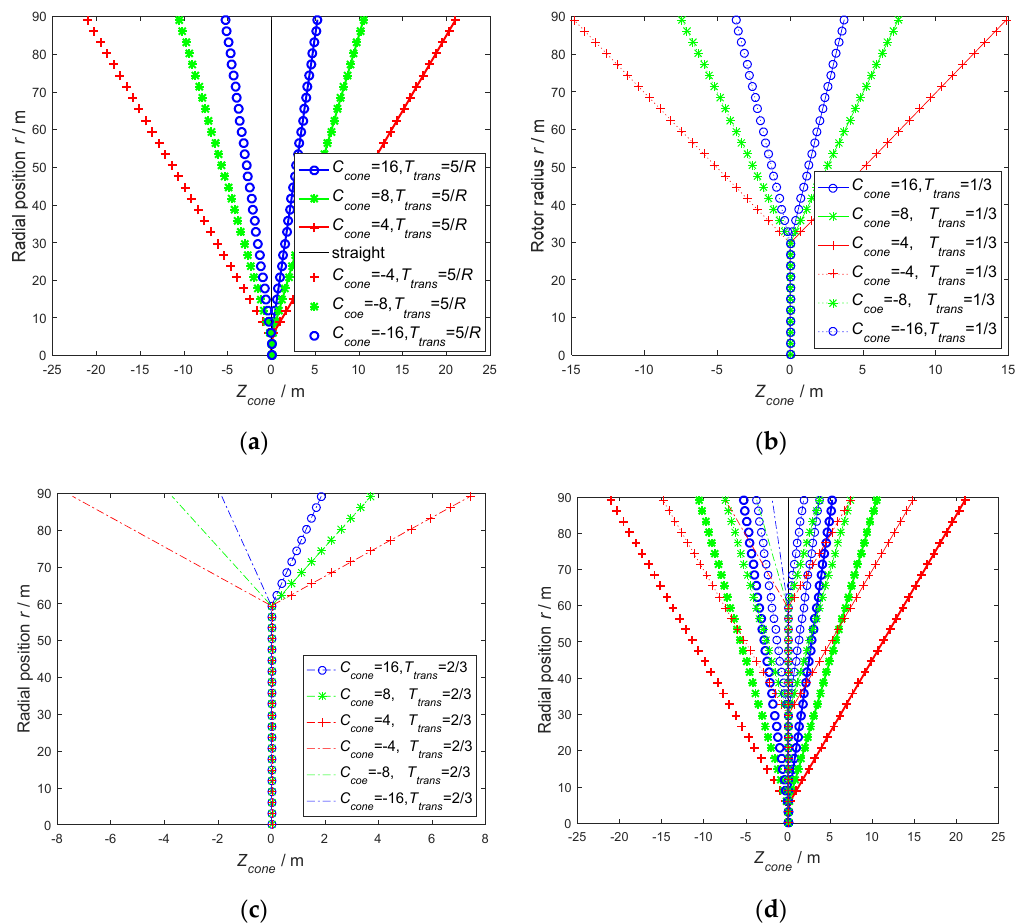
Figure 2. Different coning configurations with ±4, ±8, ±16: ( a ) T trans = 5/ R , ( b ) T trans = 1/3, ( c ) T trans = 2/3, Figure 2. Di ff erent coning configurations with ± 4, ± 8, ± 16: ( a ) T trans = 5 / R , ( b ) T trans = 1 / 3, ( c ) T trans = 2 / 3, ( d ) all of the ( d ) all of the configurations.